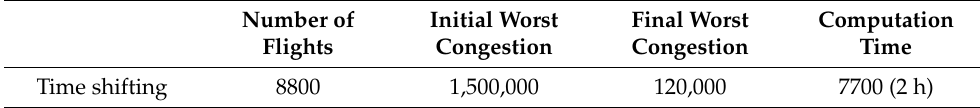
Table 1. Results of the